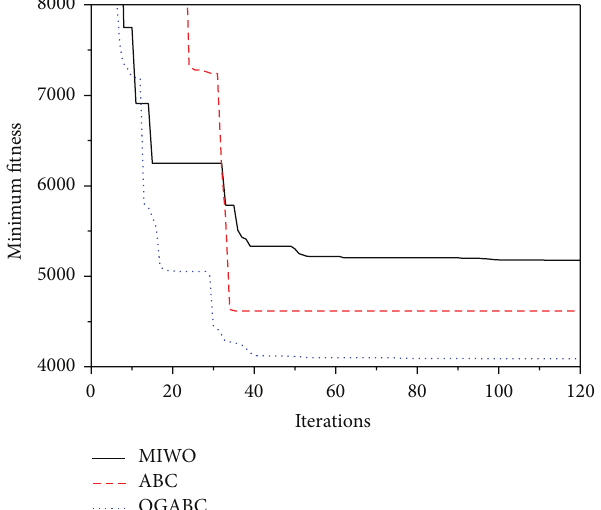
Figure 9: The comparison of the convergence curves of different